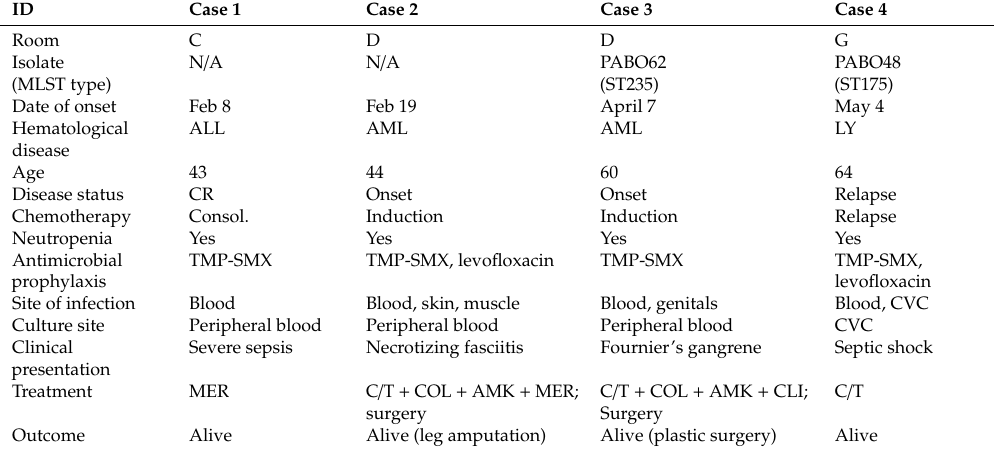
Table 1. Clinical characteristics and outcomes of patients with P. aeruginosa